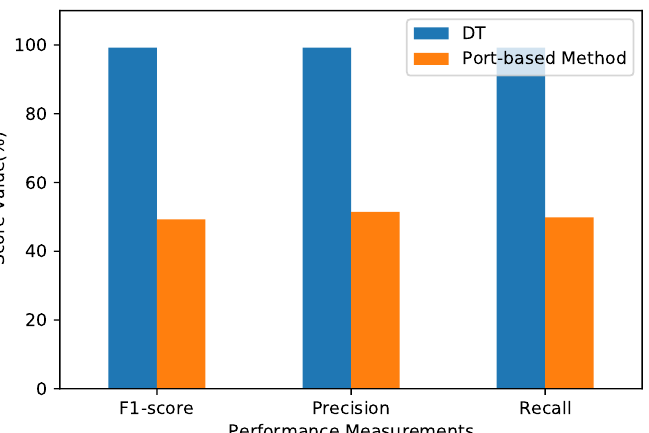
Figure 10. F1-score, precision, and recall performance measurements of DT algorithm and Port- based